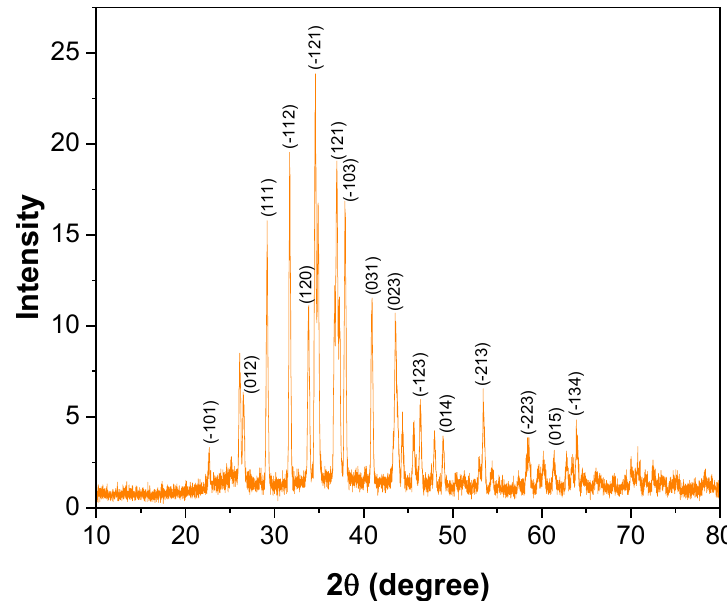
Figure 2. XRD of CNTs-Ag 2 S.